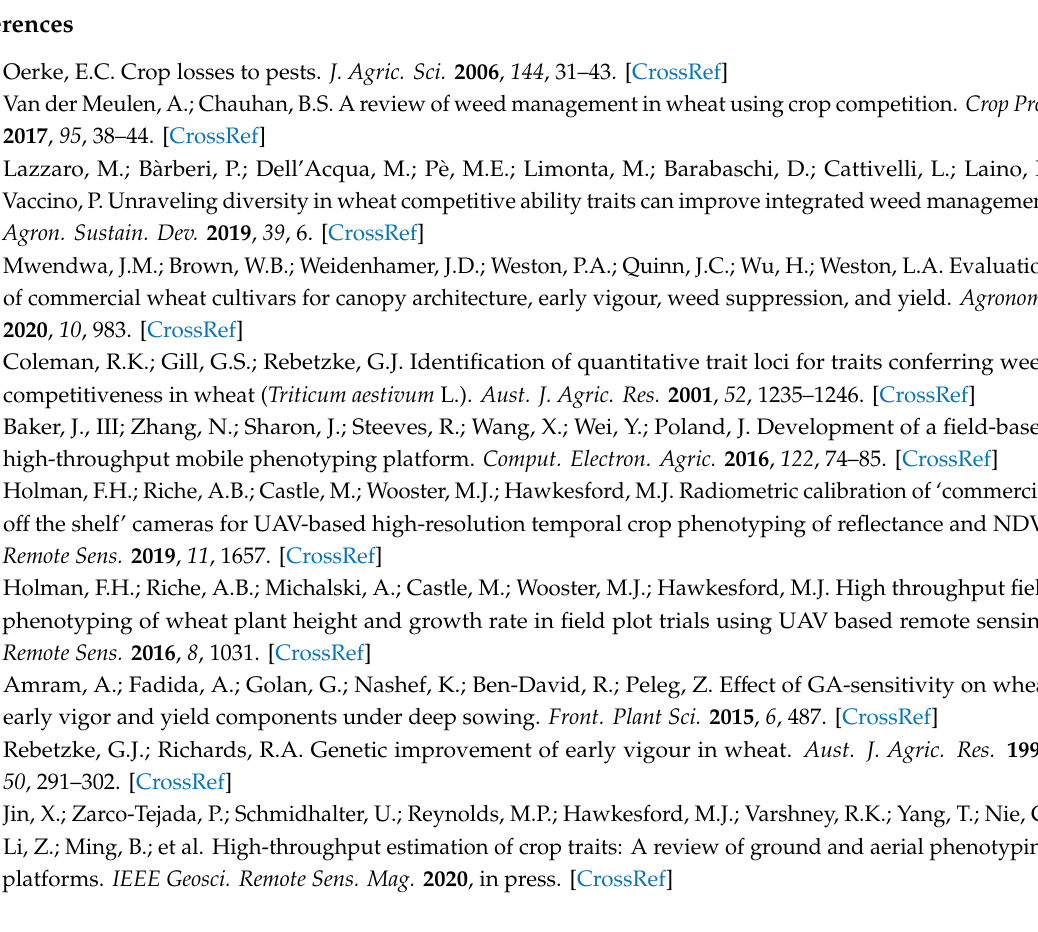
Figure S1: Illustration of the controlled conditions competition experiment. ( A ) X-1010 and ( B ) Triticale1 genotype plants imaged 6 weeks after seeding, and correspondingly, Lolium multiflorum plants that developed next to ( C ) X-1010 and ( D ) Triticale1 genotypes, Table S1: Technical specifications of the DJI Phantom 4 Pro UAV used in the field experiment., Table S2:Coe ffi cient and their standard error (in prentices) estimates from the sigmoid regression between X-1010 and triticale1 genotype volume (cm 3 ), shoot convex area (SCA) (cm 2 ), height (cm), upper-width (cm) and projected shoot area (PSA) (cm 2 ) with time (day), and their respective Root Mean Square Error (RMSE) and coe ffi cient of determination (R 2 ). Values were extracted were made between 7 and 56 days after sowing. Leaf projected shoot area was extracted from the 2-D model while height, volume, upper-width and CA from the 3-D